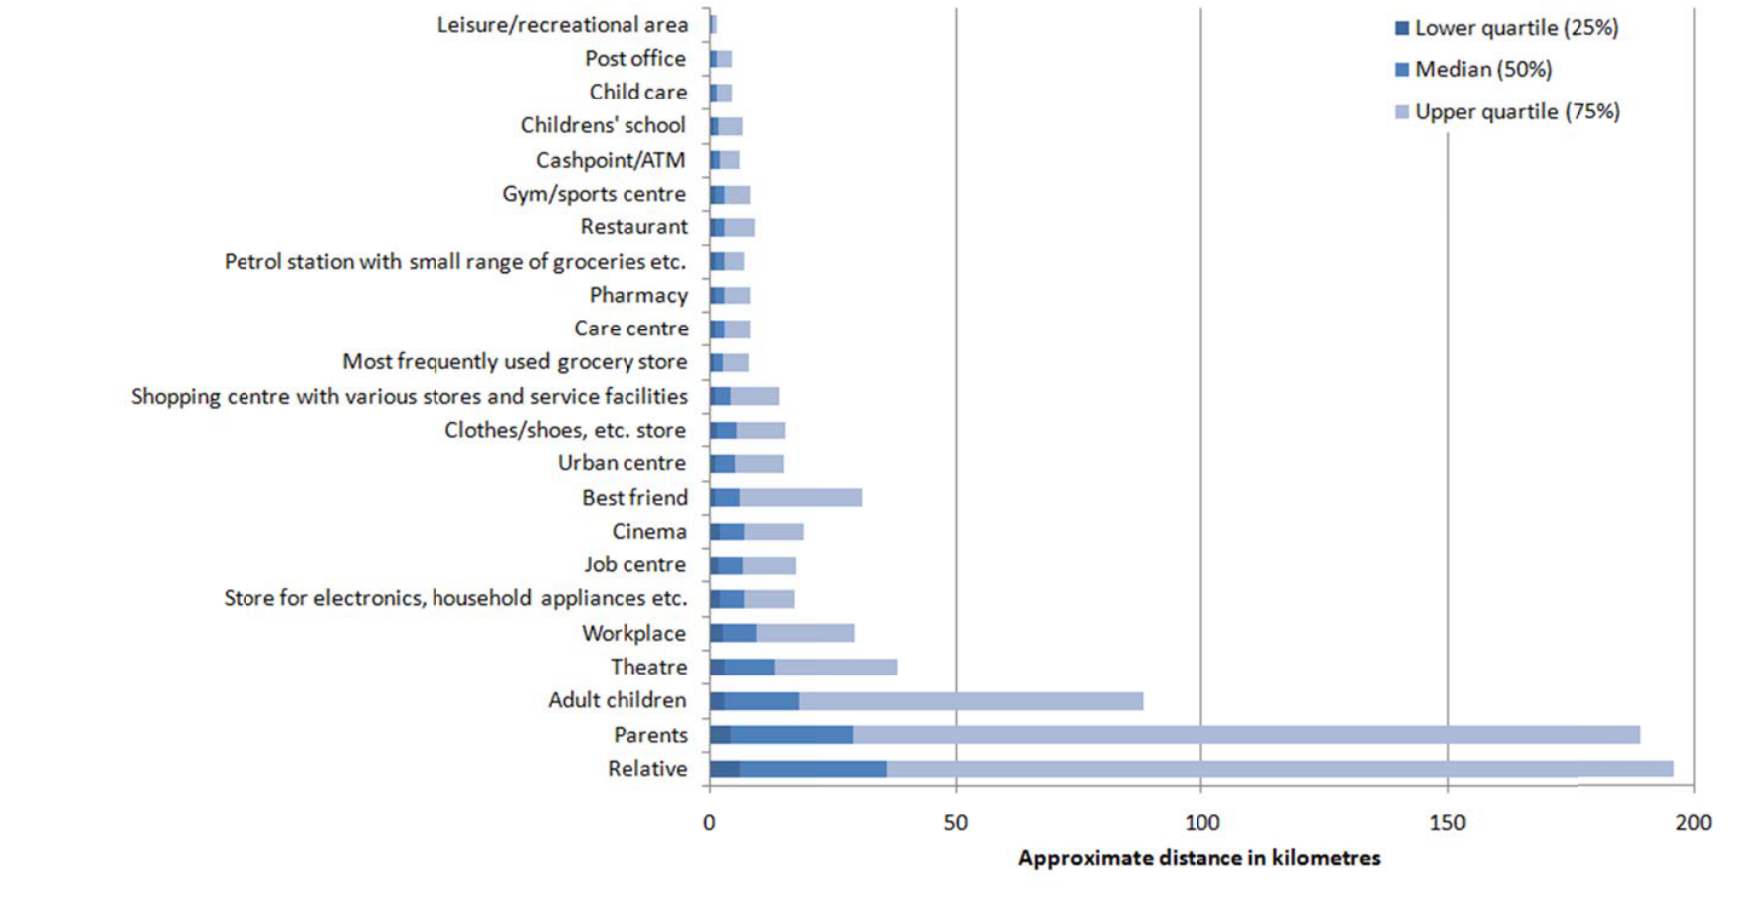
Figure 2. Approxim mate distance, in